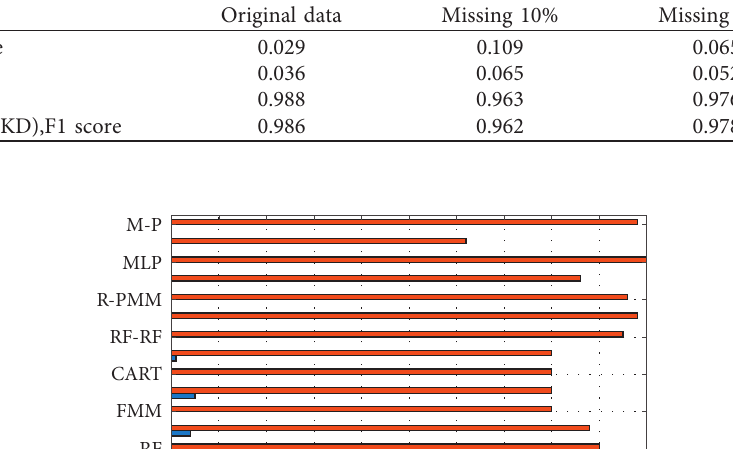
Table 4: The best feature association mining results based on traditional machine learning.